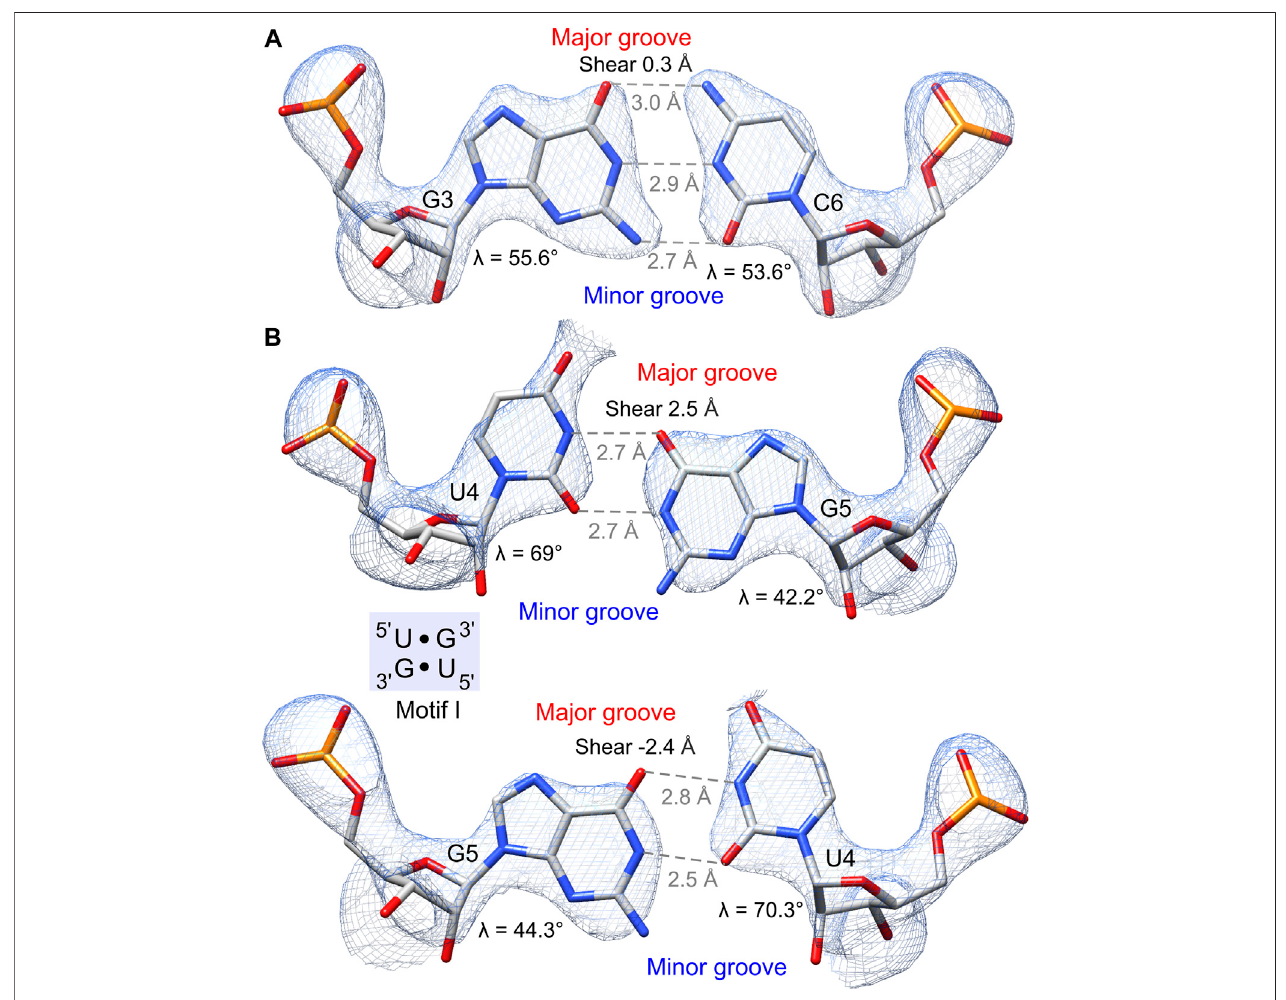
(cid:129) FIGURE3| HydrogenbondingpatternandgeometryoftheG Upairanditscanonicalcounterpart.The2 F o – F c electrondensitymap( bluemesh )ofwobblepairsis contoured at the 1.5 σ level. (A) G – C pair preceding the 5 ′ UG/3 ′ GU tandem. (B) 5 ′ UG/3 ′ GU tandem representing motif I ( light blue box ). The guanosine N7, guanosine (cid:129) O6, and the unpaired uridine O4 carbonyl group of G U pairs are exposed to the major groove and generate a region of negative potential. The non-hydrogen-bonded (cid:129) U such as shear and unequal glycosidic bond angles ( λ ) at G N2 amino groups of guanosines are positioned in the minor groove. Unique structural features of G and U are